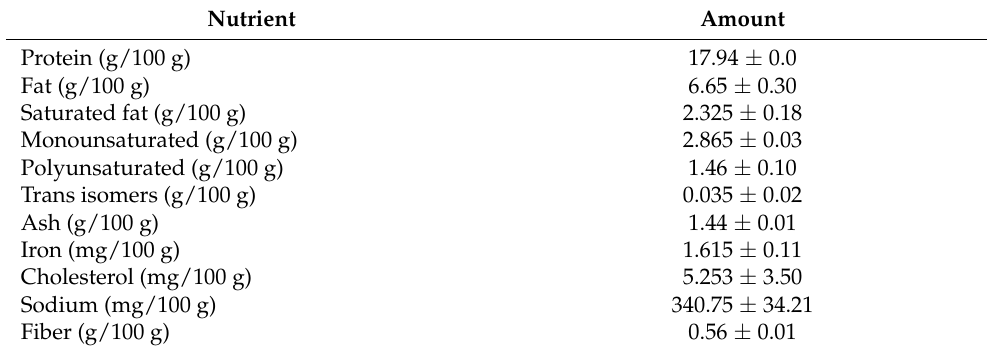
Table 9. The nutritional composition of reduced fat preservative-free pork and chicken meatballs (AI). Nutrient Amount Protein (g/100 g) 17.94 ±